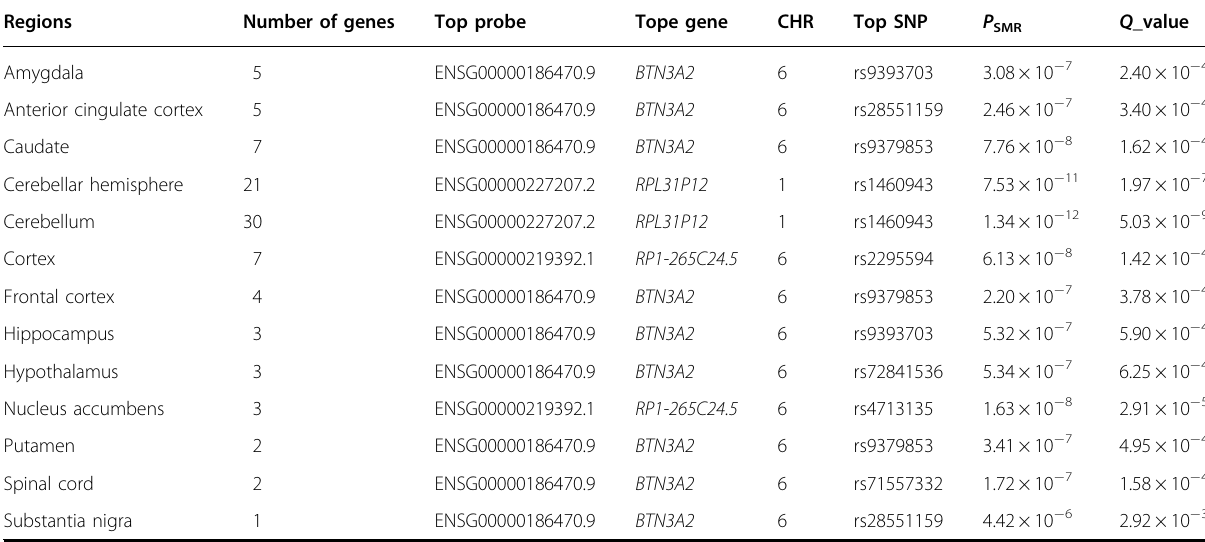
Table 2 Summary of the SMR analyses across the 13 brain regions. Regions Number of